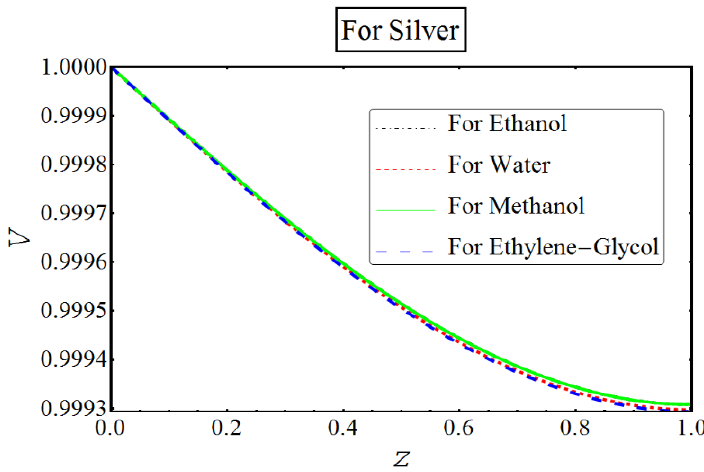
Figure 15. Behavior of azimuthal velocity for each fluid with silver particles.